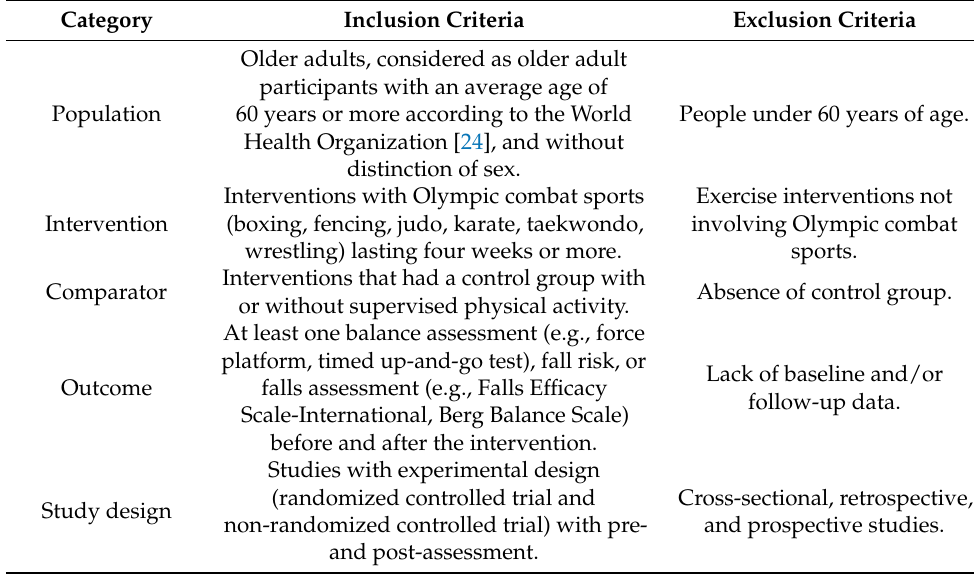
Table 1. Selection criteria used in the systematic